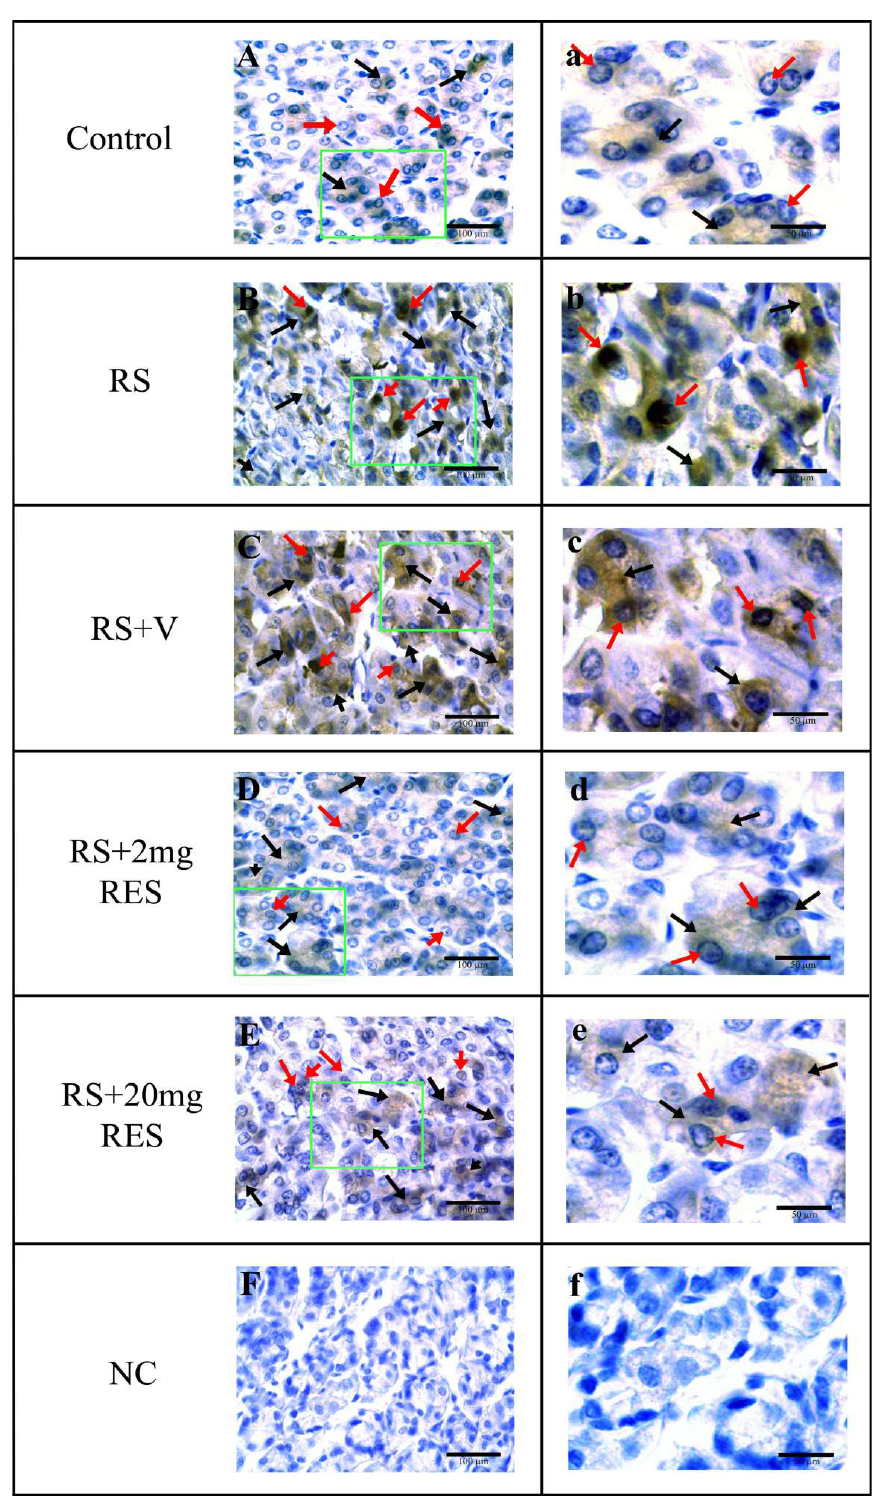
Figure 6. Immunohistochemical observations of apoptosis-inducing factor (AIF) in parietal cells of non-stressed mice (Control), restraint-stressed mice (RS), restraint-stressed mice with vehicle (RS + V), restraint-stressed mice treated with 2 mg/kg body weight of resveratrol (RS + 2 mg RE), restraint-stressed mice treated with 20 mg/kg body weight of resveratrol (RS + 20 mg RES), and the negative control (NC). Red arrows point to the nucleus and black arrows point to the cytoplasm. Scale bar is 100 μm ( A – F ) and 50 μm ( a – f ).